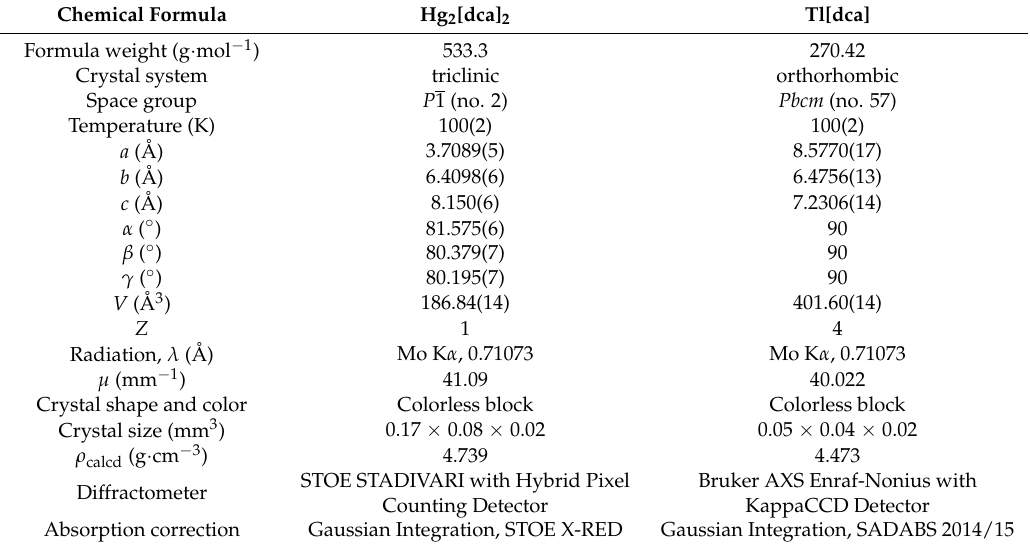
Table 4. Summary of single-crystal X-ray diffraction structure determination data of Tl[dca] and Hg 2 [dca] 2